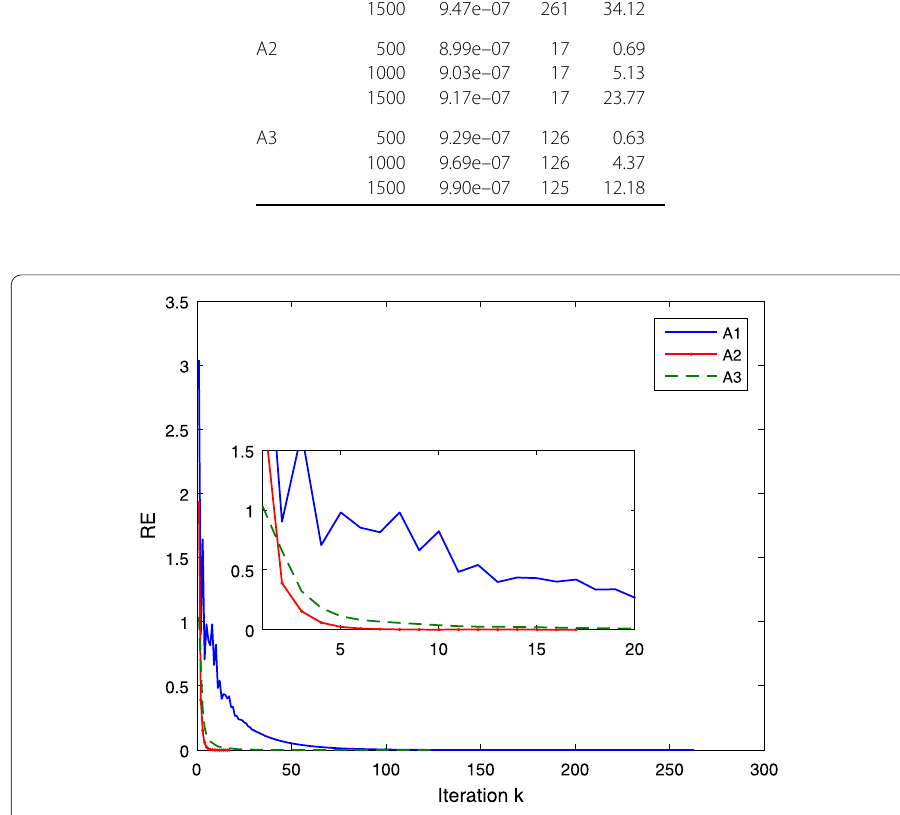
Figure 1 When n = 1000 the change of RE of A1, A2 and A3 with the iteration number increasing